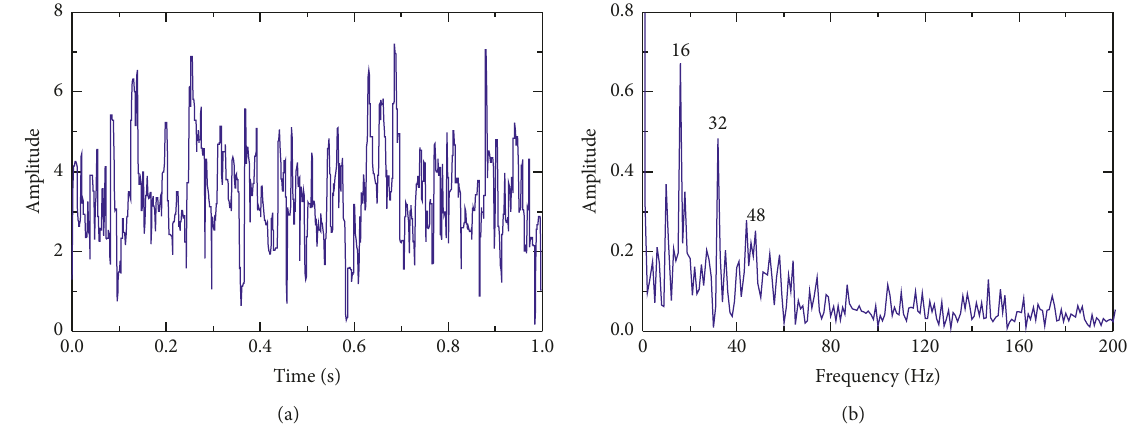
Figure 8: Impulsive extracting results of traditional MMF: (a) waveform; (b) frequency spectrum.